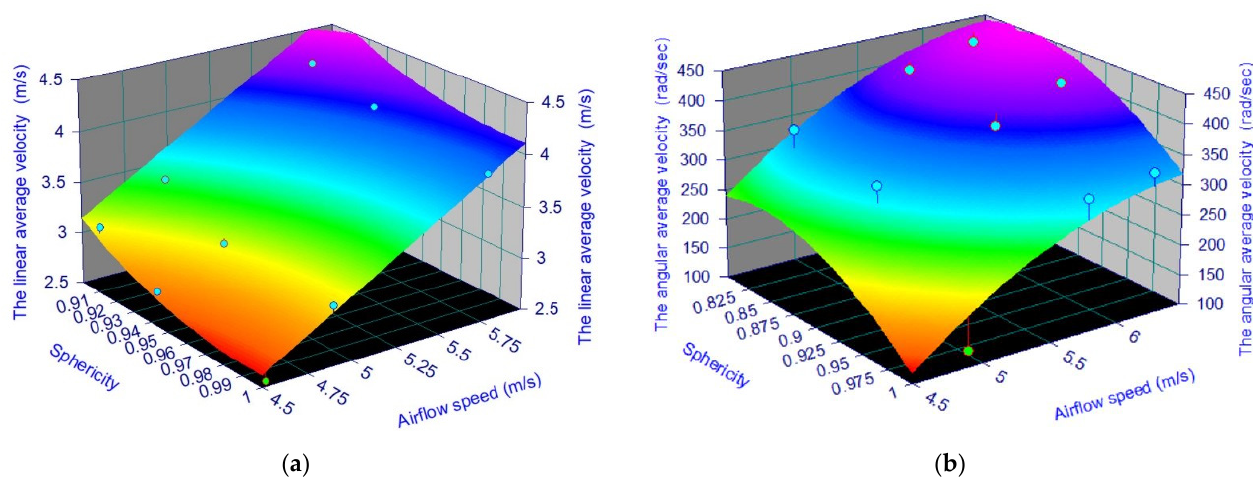
Figure 11. The response surfaces corresponding to the selected equation [44] are shown as follows: ( a ) for the average instantaneous velocity of a particle with dimensions of 47 mm; ( b ) for the average angular velocity of a particle with a diameter of 27 mm. Table 2. The correlation coefficients r 2 value for both speeds [44].